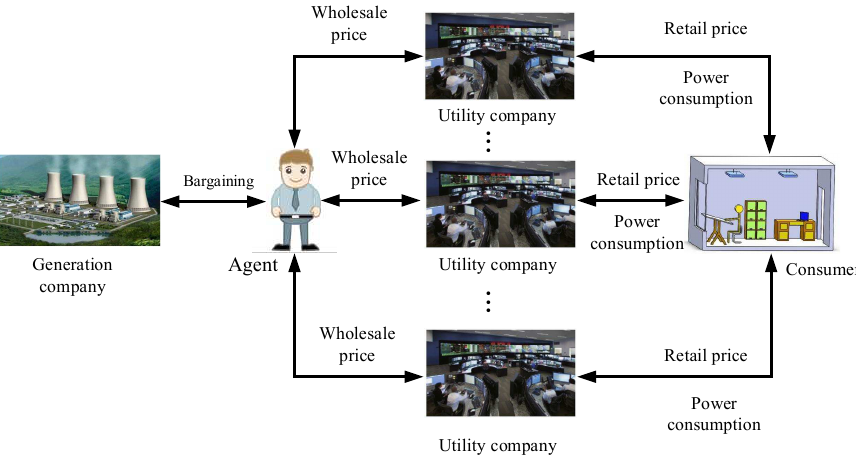
Figure 3. System